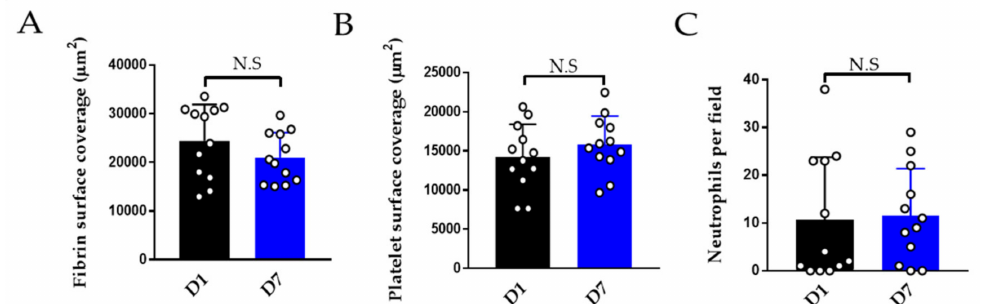
Figure 6. Effect of storage on performance of the thromboinflammation chip. Whole blood was perfused on endothelialised chips stored for one day versus seven days after fixation. ( A ). Fibrin ( B ) platelet surface coverage and ( C ) neutrophils per × 40 field on one-day-old (black columns) versus seven-day-old chips (blue columns) from HUVECs from the same cord (four cords in total). Data is mean ± SD of 12 fields of view from n = 4 separate donors. N.S = non-significant by two-tailed, non-parametric t -test